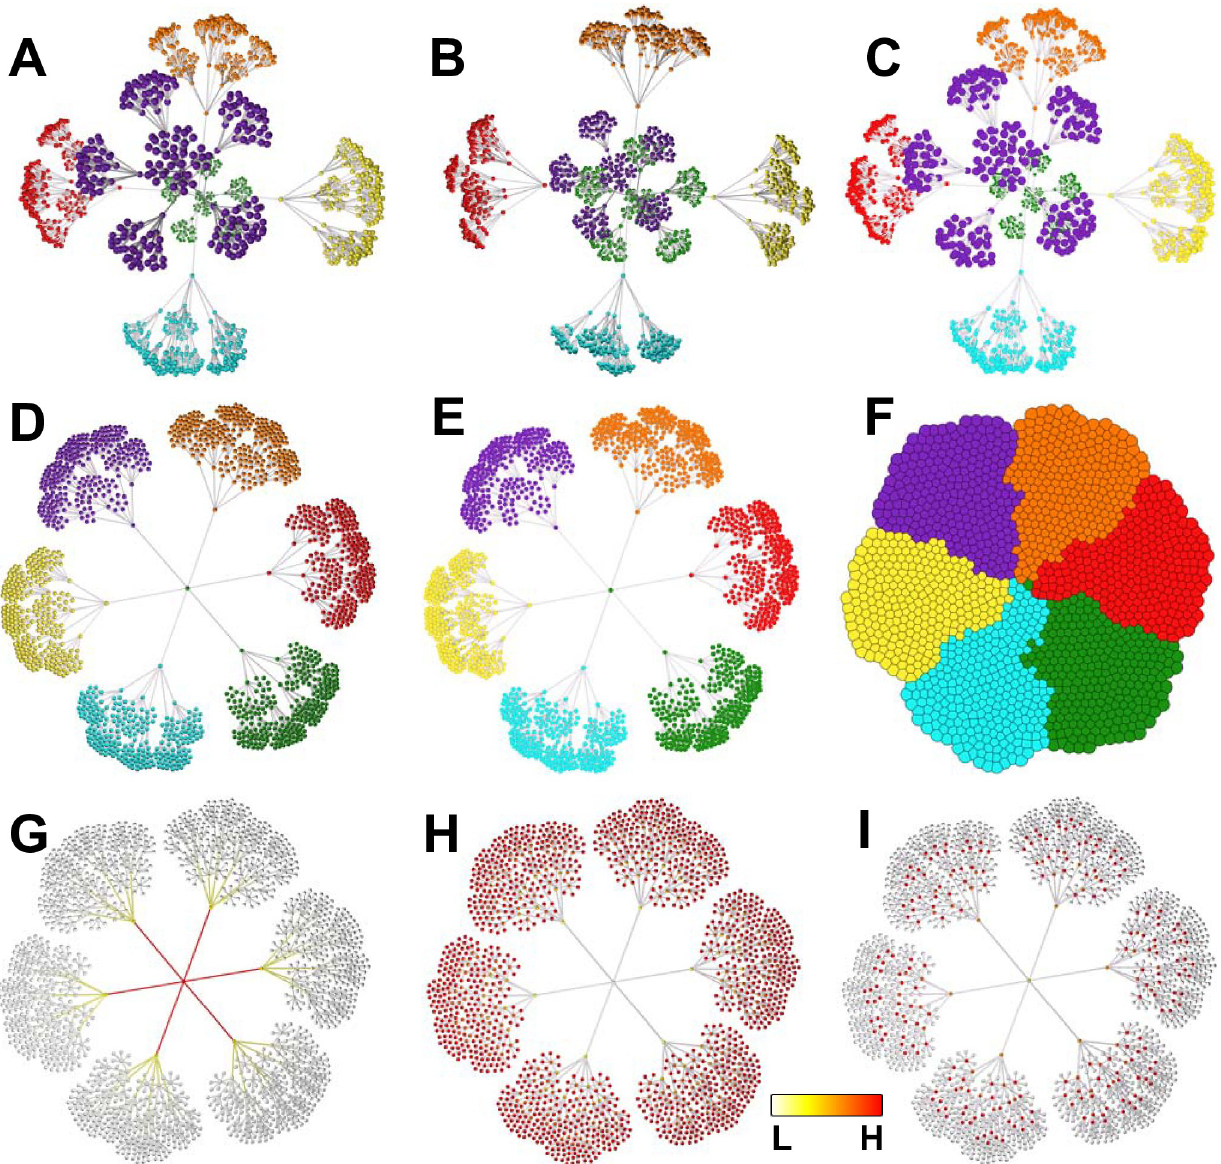
Fig 2. Different graph visualisation options. (A) 3D perspective view, smooth shading (the default), with visualisation of node categorical attribute (MCL cluster). (B) 3D orthographic view, flat shading (no perception of distance—all nodes same size, unless sized by attribute value). (C) 3D perspective view, smooth shading. (D) 2D view, smooth shading. (E) 2D view, flat shading. (F) compressed 2D layout, flat shading, showing node overlap view. Visualisation of (G) Betweeness centrality values, (H) Eccentricity values, (I) PageRank values. G-I are continuous (numerical) attributes, so a colour spectrum and size gradient is used for node display (2D, smooth shading). Betweenness and eccentricity are calculated for both nodes and edges, therefore visual encoding is applied to both.